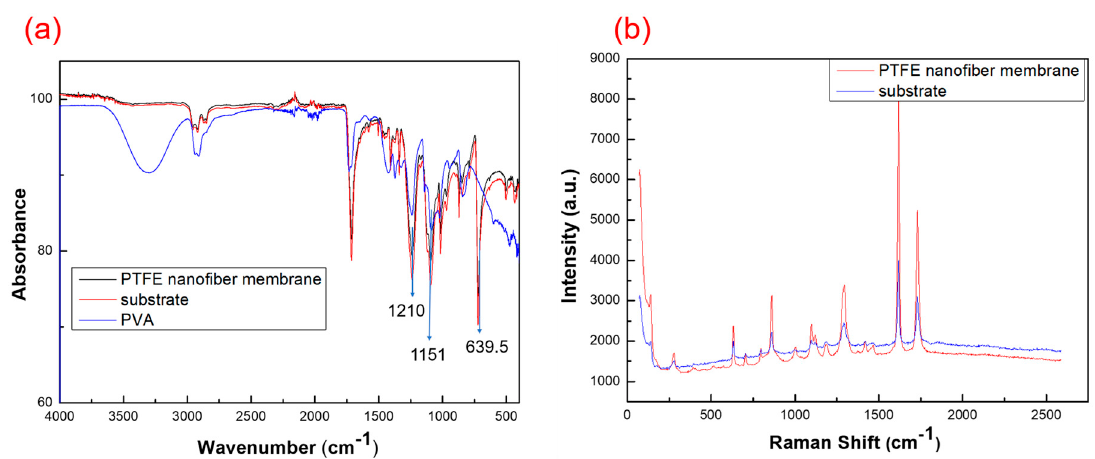
Figure 4. Composition comparison of PTFE nanofiber membrane and substrate. ( a ) Infrared spectroscopy image; ( b ) Raman spectroscopy image.